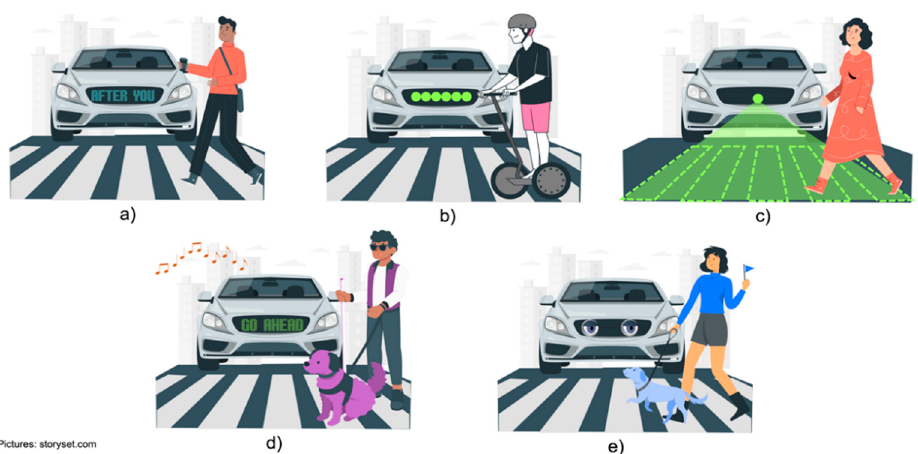
Figure 8. Representation of visual interfaces, ( a ) display on the front of the vehicle showing in text information on what the pedestrian should do, ( b ) LED strip lights on the front of the vehicle in different sequences of movement and colors according to the type of message, ( c ) projection of message on the road with visual elements to indicate to the pedestrian the option of “safe crossing”, ( d ) acoustic and visual interface to indicate the action to follow by the pedestrian, ( e ) vehicle with human appearance to emulate the communication by visual contact.